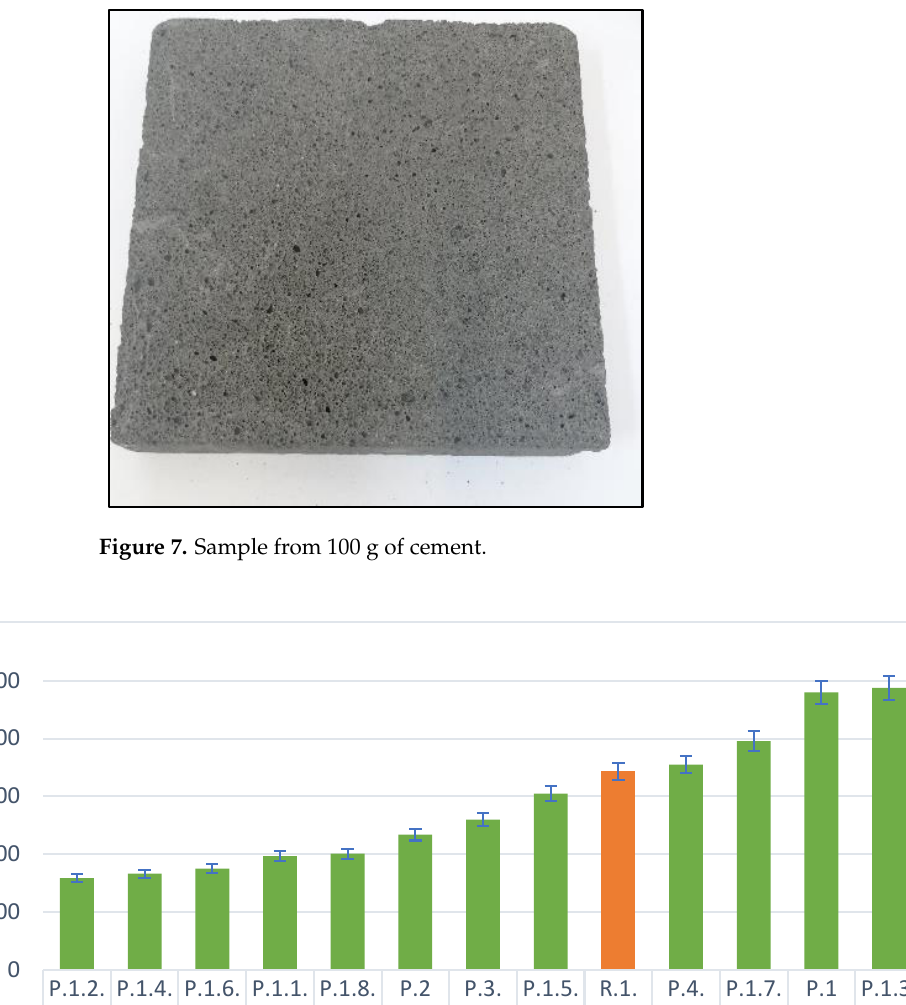
Figure 7. Sample from 100 g of cement.